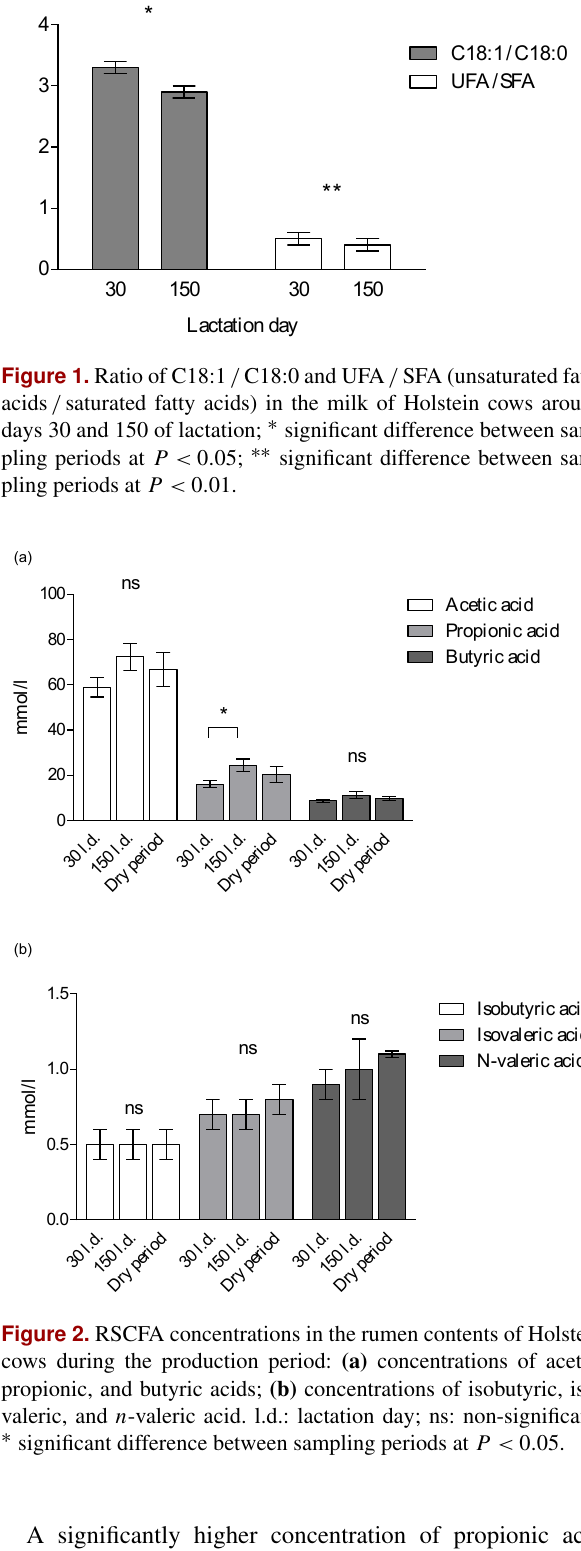
A significantly higher concentration of propionic acid around day 150 ( P = 0.04) compared to day 30 of lacta- tion is shown in Fig. 2a. Concentrations of acetic and butyric acids showed no significant differences among the